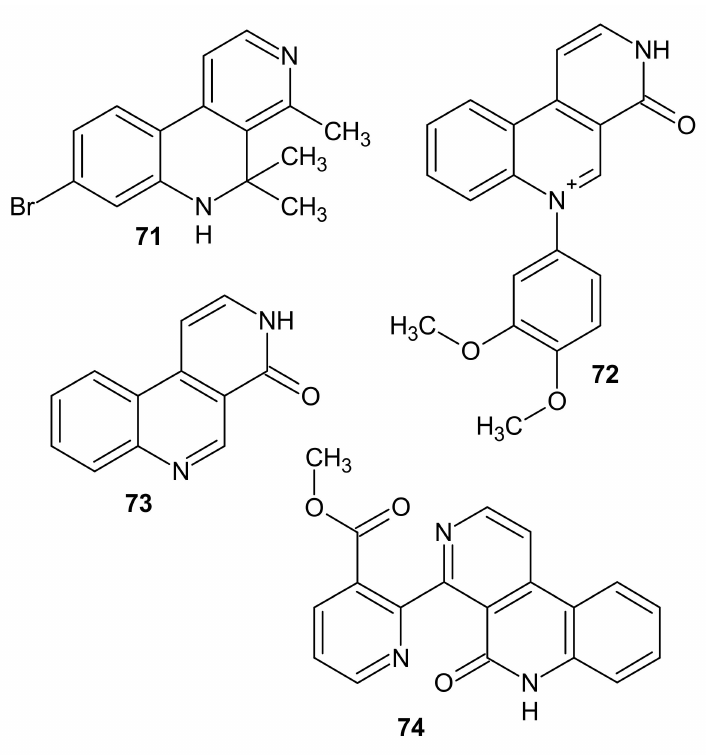
Figure 24. Structures of benzo[2,7]naphthyridine alkaloids 71 – 74 . Alkaloids: 6-(3,4-dimethoxyphenyl)-3 H -benzo[ f ][2,7]naphthyridin-6-ium-4-one